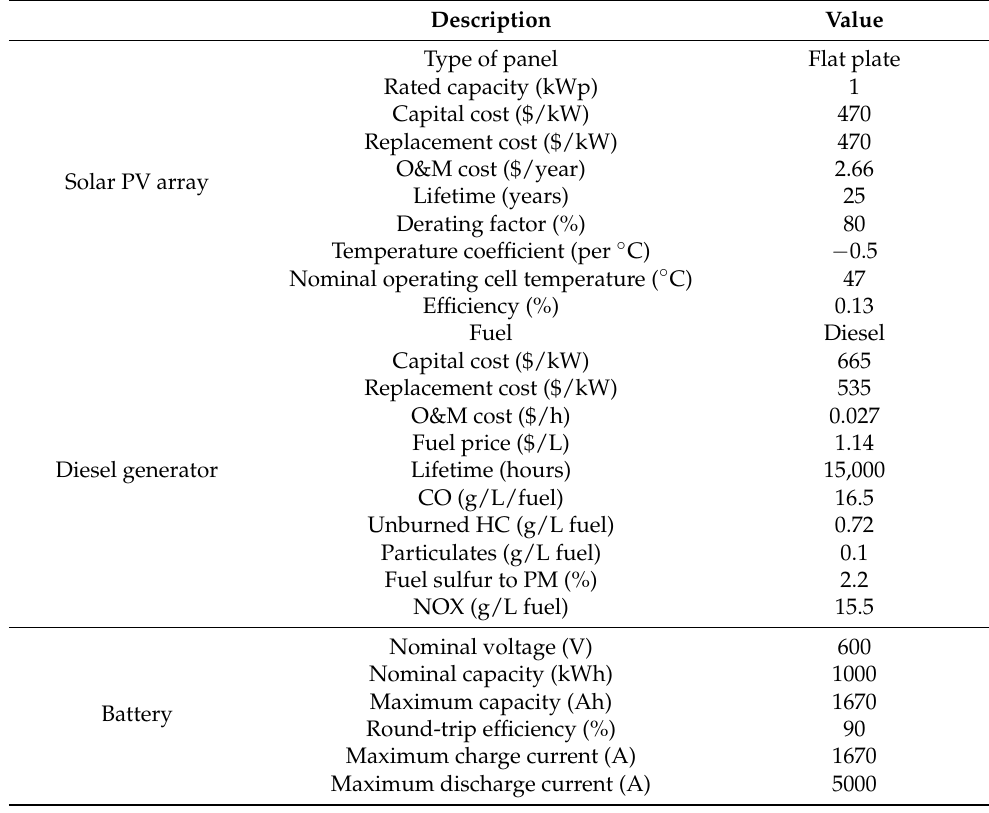
Table A1. Technical details of solar PV array, DG, and